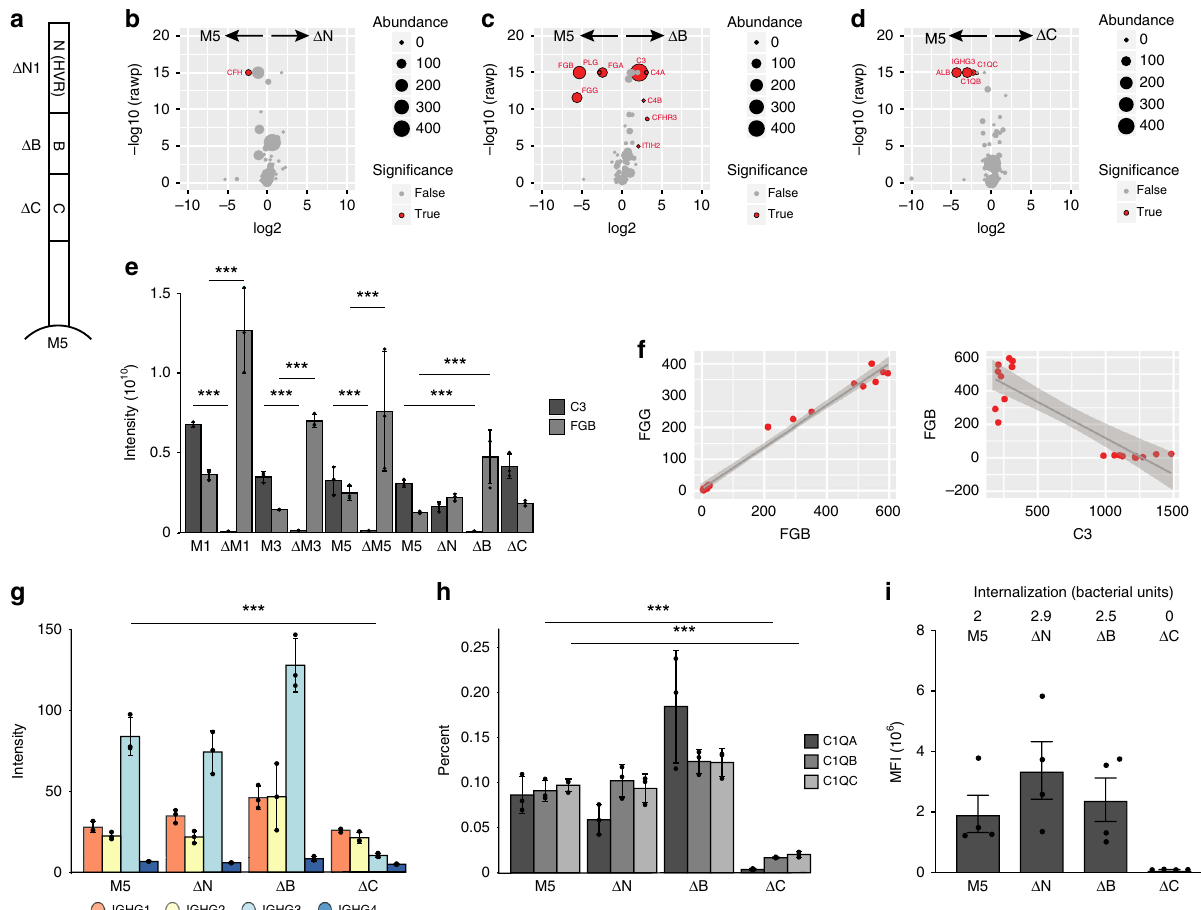
Fig. 8 Localization of opsonizing antibodies on the M5 protein. a Schematic representation of the M5 protein, and the arrangement of the different domains (N, B, and C). Volcano plots comparing the SA – DIA plasma interactome of the wild-type M5 protein to the: b Δ N1 mutant strain, c Δ B mutant strain, and d Δ C mutant strain. In panels b – d a red sphere indicates a human protein with a signi fi cant difference in the compared interactomes, while a gray sphere indicates no signi fi cant difference, in the interaction between the wild-type and the respective mutant strain. The data was fi ltered using a log2 fold enrichment of >2 and an adjusted P- value < 0.05 using the Welch ’ s t -test. The size of the spheres indicates protein abundance as measured in SA – DIA. e A comparative analysis of the relationship between fi brinogen and complement C3 bound to the surface of the bacteria in all SA – DIA experiments used in this study. In all M protein mutant strains studied, the binding of fi brinogen to the surface of the bacteria is signi fi cantly reduced compared to the wild-type bacteria (indicated with *** P- value < 0.001 using the Welch ’ s t -test), as the binding of complement C3 increases on the surface of mutant bacteria. f Correlation analysis between fi brinogen and C3 reveals that the two proteins display a highly competitive mode of binding. g IgG subclass distribution between wild-type M5 strain and its different derivative mutant serotypes. IgG3 has speci fi c af fi nity for the C-repeat region of the M5 protein. h C1QA-C association with wild-type M5 strain and the different derivative mutant serotypes. C1QB and C1QC both have speci fi c af fi nity for the C-repeat region of the M5 protein, mediated by IgG3 Fc-binding. Q1QA was detected with one peptide only, Q1QB and C1QC each with two peptides. i Flow cytometry-based interaction (phagocytes associated with bacteria) and internalization (average number of bacteria inside phagocyte) of the wild-type M5 strain and different mutant strains with human THP-1 monocytes. The data is based on four separate experiments. Error bars in panels e , g , and h are expressed as standard deviation (s.d.) from the mean and in panel i as standard error of the mean (s.e.m). All experiments were prepared using n = 3 biologically independent samples, except in panel i , where n = 4 biologically independent samples were used. Source data are provided as a Source Data fi